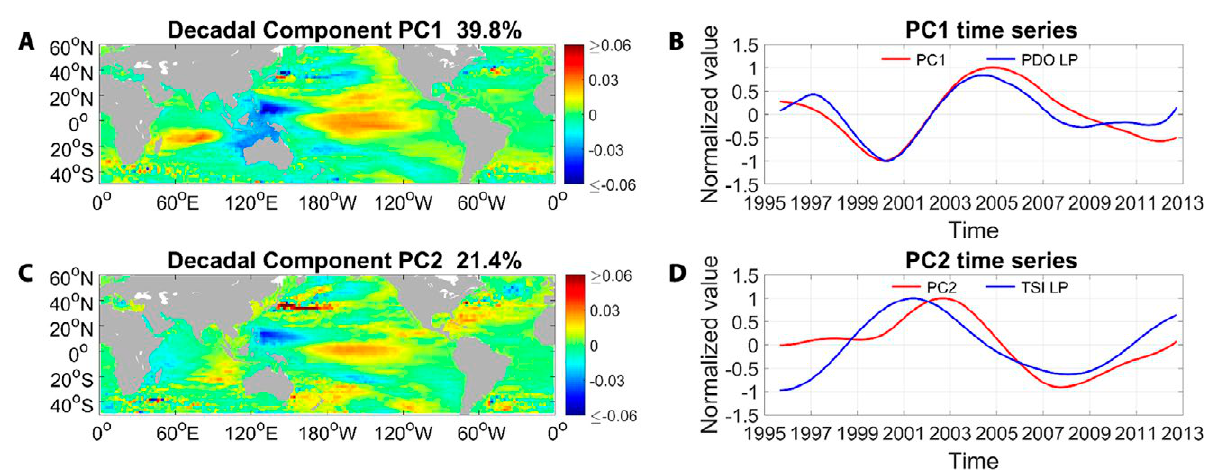
Fig. 1. – Spatial patterns of the first dominant mode EOF1 (A) and its corresponding (normalized) time-series t_EOF1 (B) computed from the de-trended 5-month running mean of decadal component of AVISO sea level data for the period 1993-2012. De-trended low-pass-filtered indices of the PDO are added in subplot